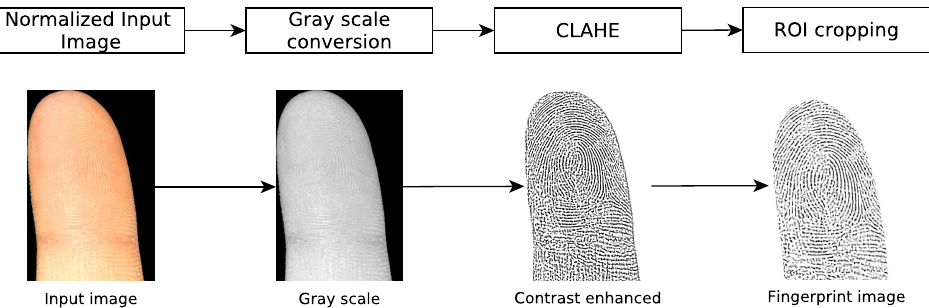
Figure 5. Overview of grayscale conversion, application of CLAHE, and cropping of the fingerprint region Of interest (ROI). This process is executed on every separated